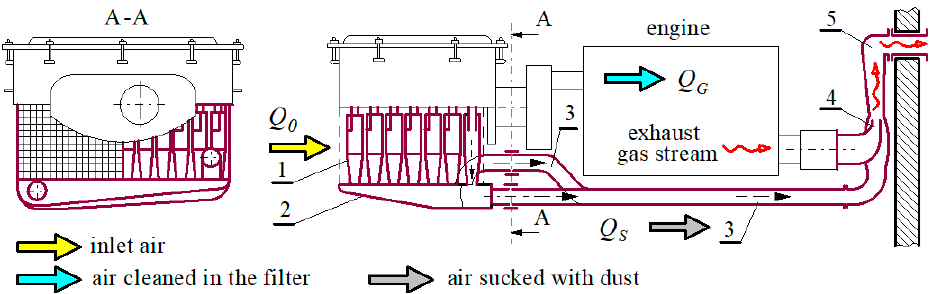
Figure 18. The system of ejective dust suction using the suction flow from the air filter multicyclone of the T-72 tracked vehicle: 1—multicyclone, 2—dust collector, 3—suction ducts, 4—ejectors, 5—exhaust gas pipe.